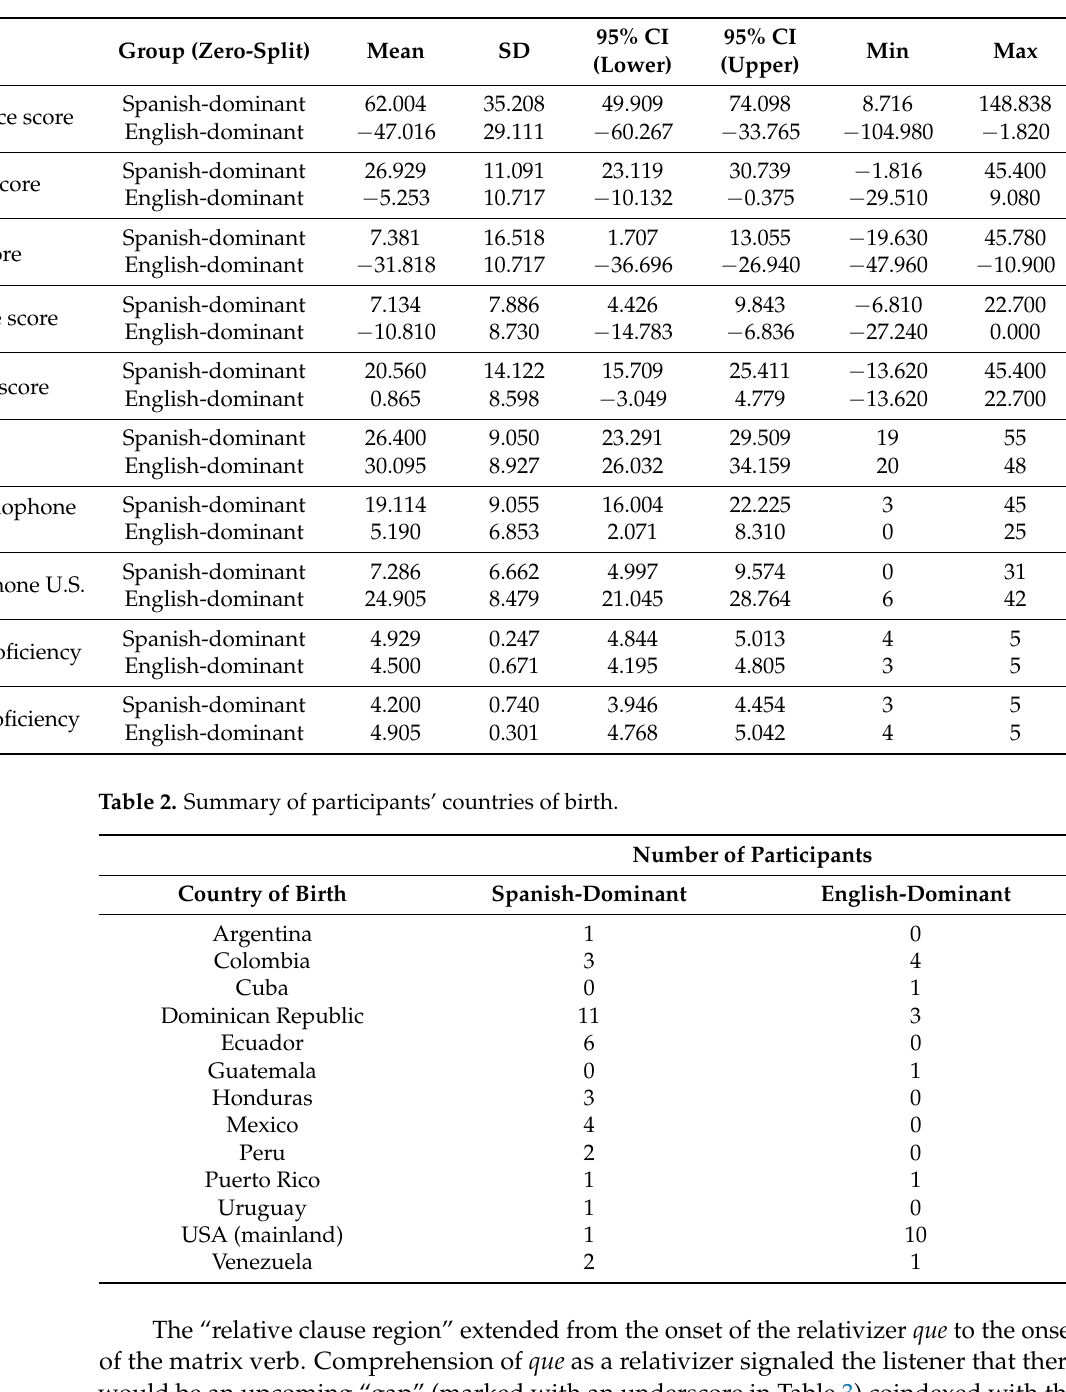
Table 1. Summary of participant characteristics. For the sake of illustration, participants are divided into the groups “Spanish-dominant” and “English-dominant” based on a zero split; however, there was no group variable in any of our inferential analyses.